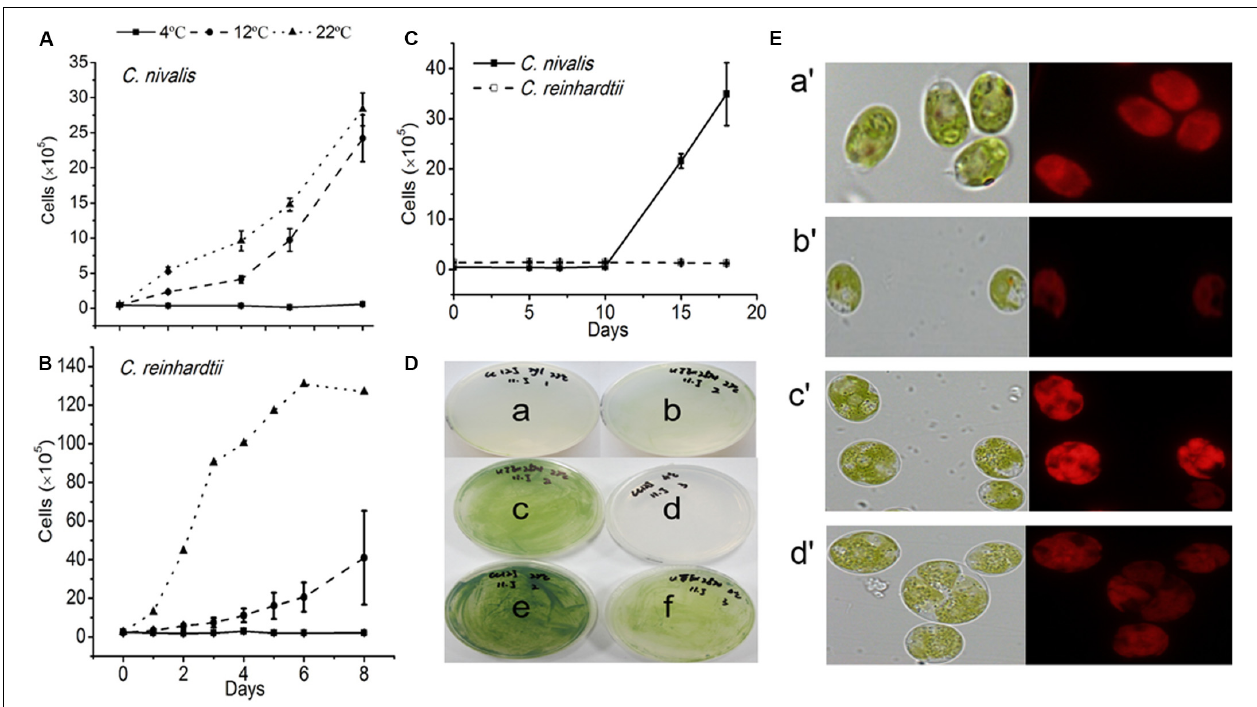
FIGURE 1 | The growth rates and states of C. nivalis and C. reinhardtii at different temperatures. (A,B) Growth curves of C. nivalis and C. reinhardtii under static culture at 4, 12, and 22 ◦ C. (C) Growth curves of C. nivalis and C. reinhardtii under shaking culture at 4 ◦ C. (D) C. nivalis and C. reinhardtii cells cultured on a solid medium at 22 and 4 ◦ C. (a,b) Growth of C. reinhardtii and C. nivalis , respectively, after 0 days. (c,f) Growth of C. nivalis for 20 days at 22 and 4 ◦ C, respectively. (d,e) Growth of C. reinhardtii for 20 days at 4 and 22 ◦ C, respectively. (E) Changes in cell size and chlorophyll fluorescence based on assessment of 10 5 cells under 22 ◦ C